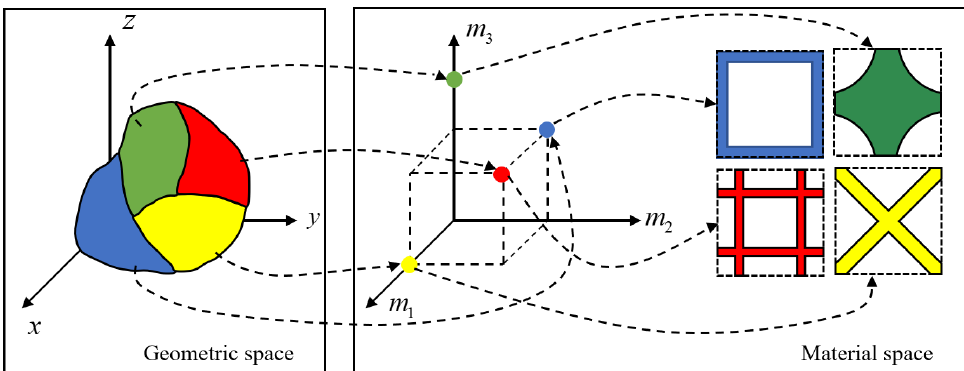
Figure 1. The CAD model of the ideal lattice material component.